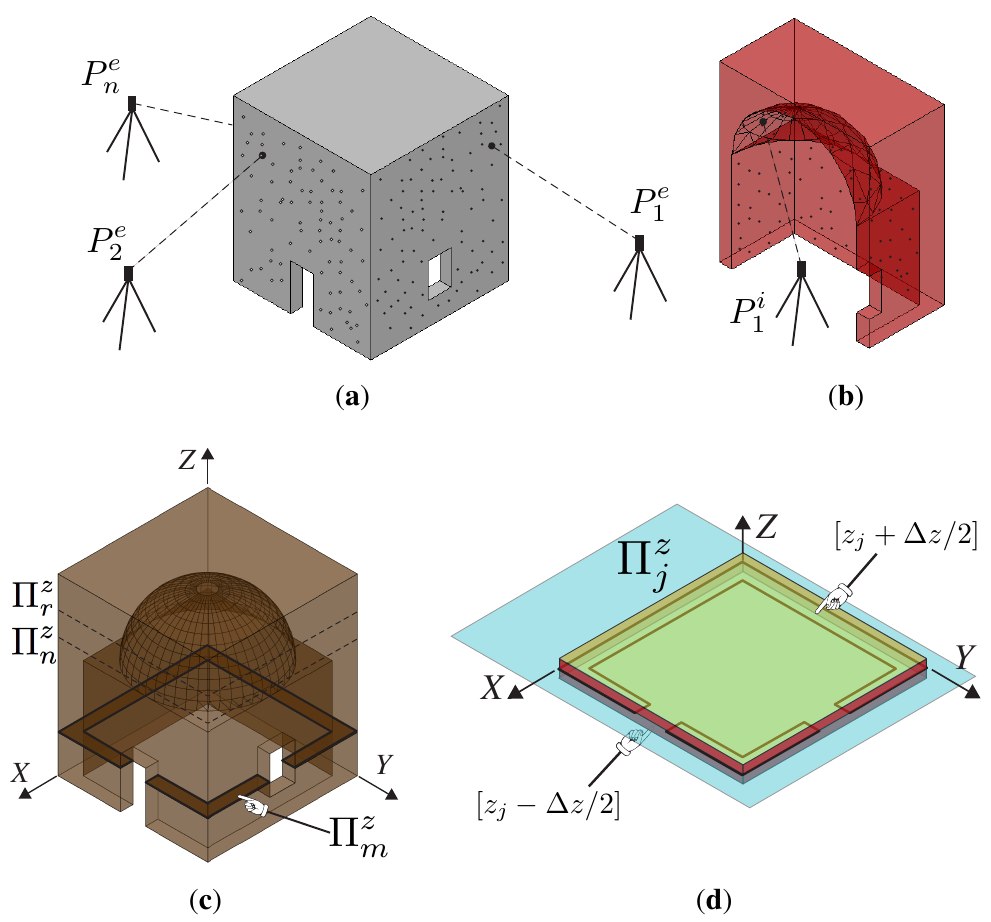
Figure 2. Visualization of the stacking layer sequence concept. ( a ) Point cloud survey of external façades; ( b ) point cloud survey of internal surfaces; ( c ) illustration of the m -th slice; ( d ) Π z j